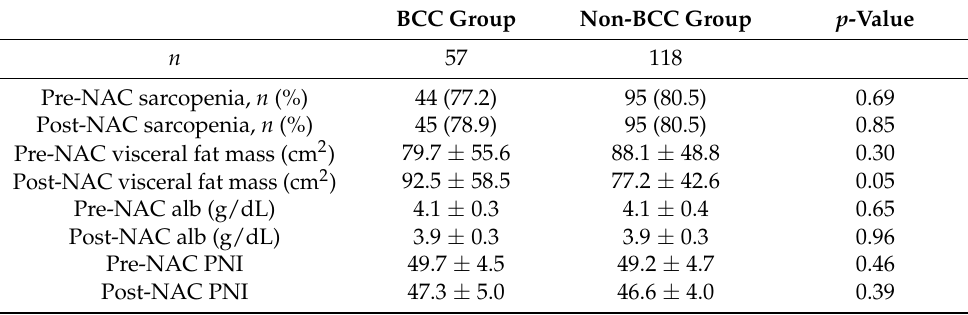
Table 4. Body composition and nutrition parameters pre- and post-NAC in BCC group. BCC